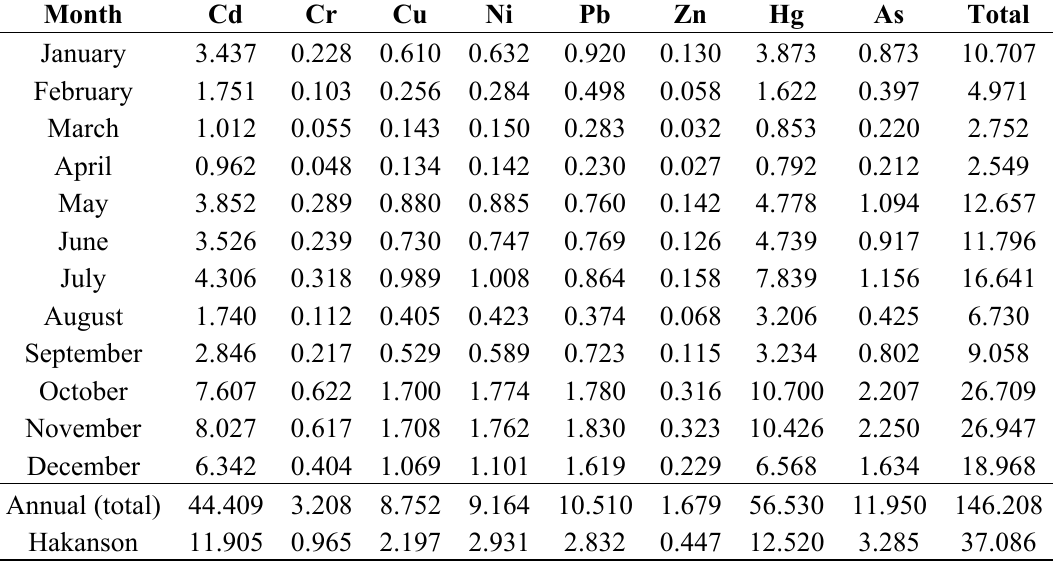
Figure 6. Annual G2 met index map for the total risk (cell size: 500 m; value ranging: histogram equalization; mean value: 146.2). Table 3. Mean values of G2 met layers per heavy metal and month (Hakanson values included for